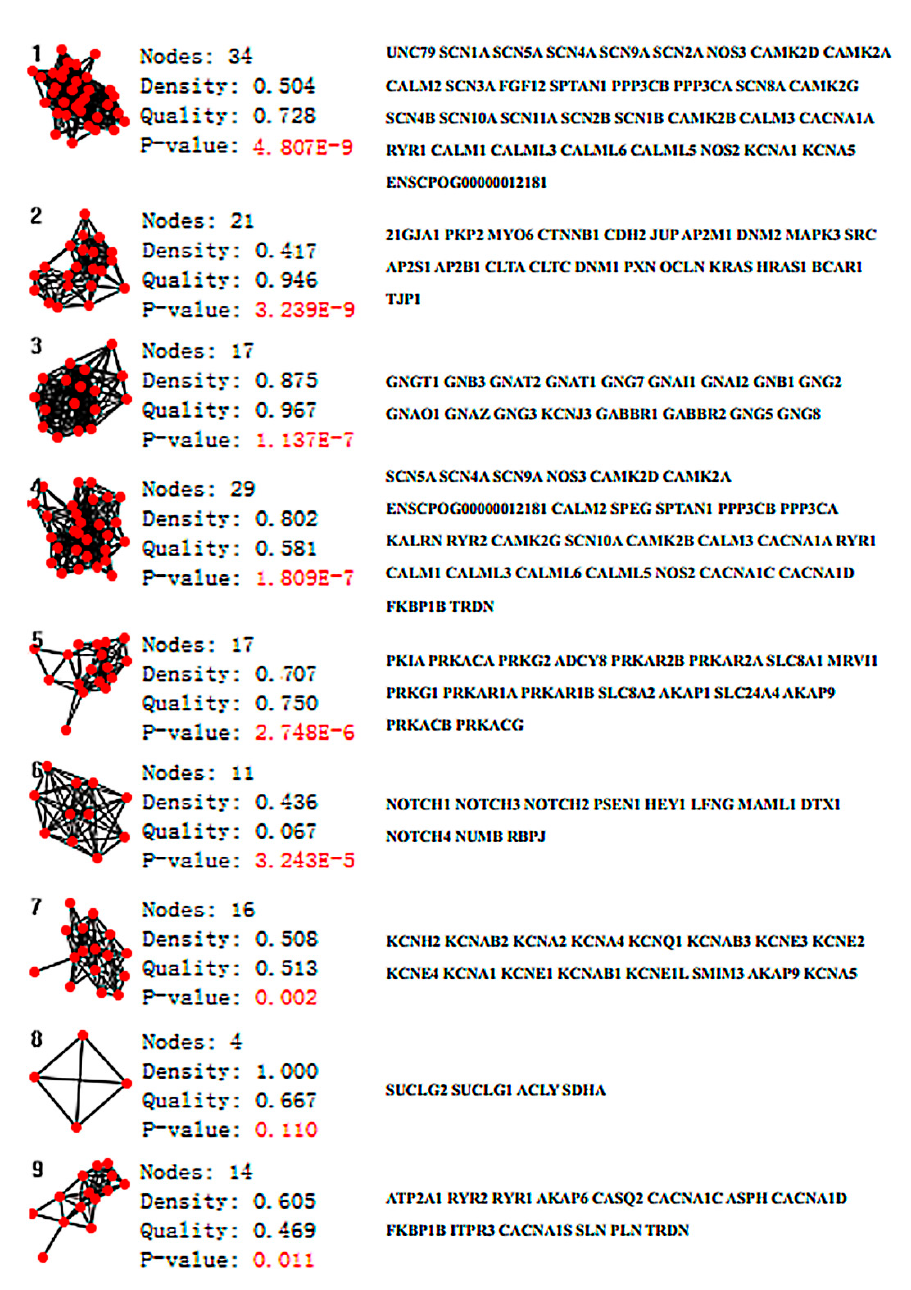
Figure 7. Sub-graphs of the PPI network of aconitine alkaloids induced cardiotoxicity analyzed using the ClusterONE plugin.